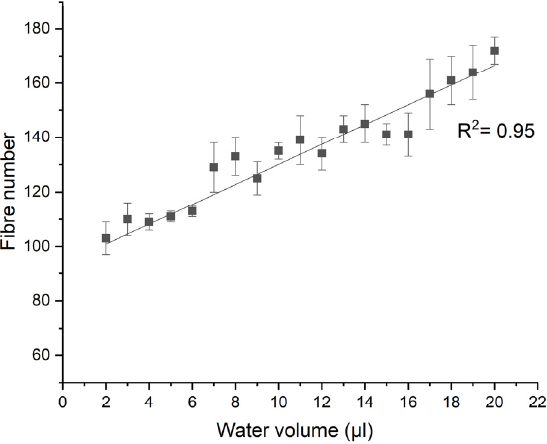
Figure 8. Graph displaying the effect of water droplet volume on the number of fibres covered on the untreated sample surface.